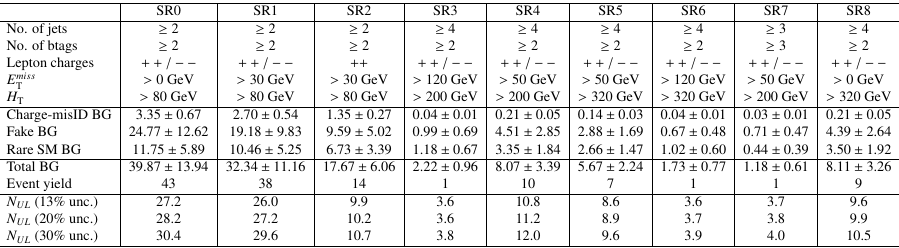
Table 1. A summary of the combination of results for this search. For each signal region (SR), we show its most distinguishing kinematic requirements, the prediction for the three background (BG) components as well as the total, and the observed number of events. SR0 SR1 SR2